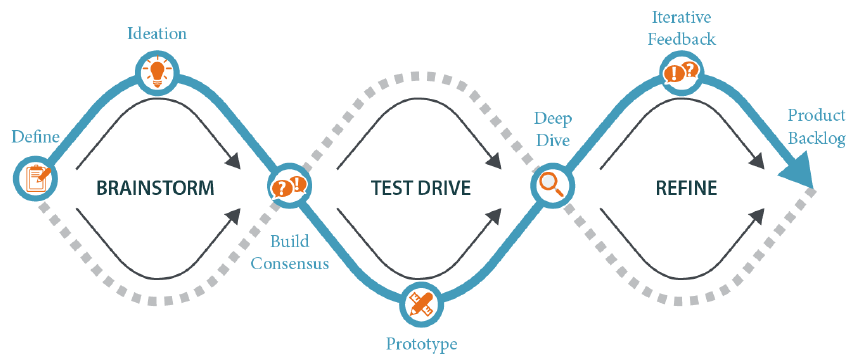
Figure 2. Example Framework of a Generic TIDE.